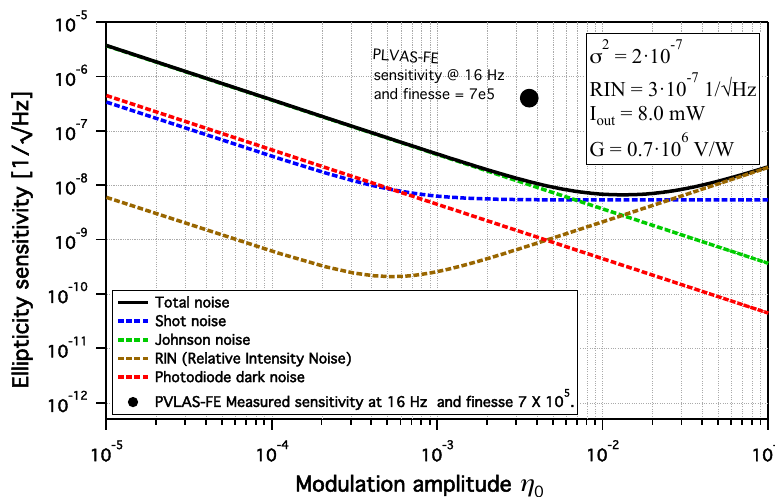
Figure 6. Intrinsic peak noise components of the polarimeter as a function of the ellipticity modulation amplitude η 0 . Superimposed is the PVLAS-FE peak ellipticity noise at 16 Hz well above the expected sensitivity due to the Fabry–Perot mirrors (see Section